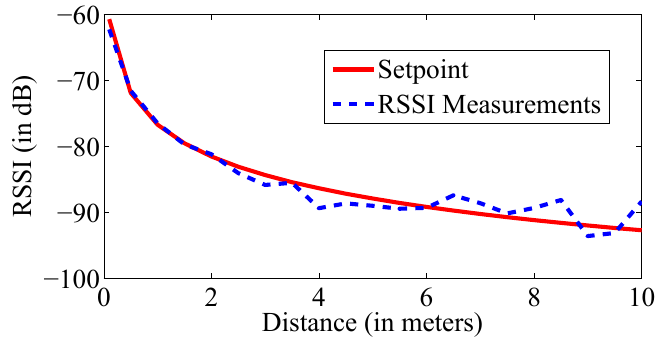
Figure 3. Impact of the path loss